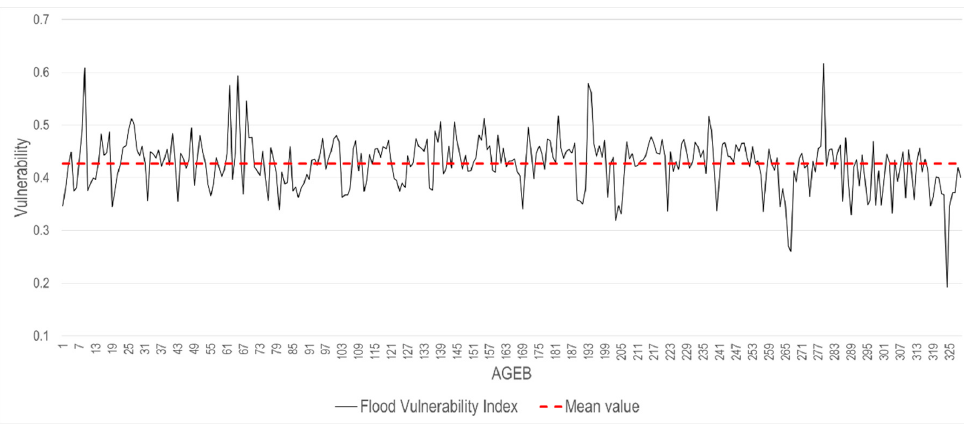
Figure 10. Composed flood vulnerability index values for the studied AGEB.